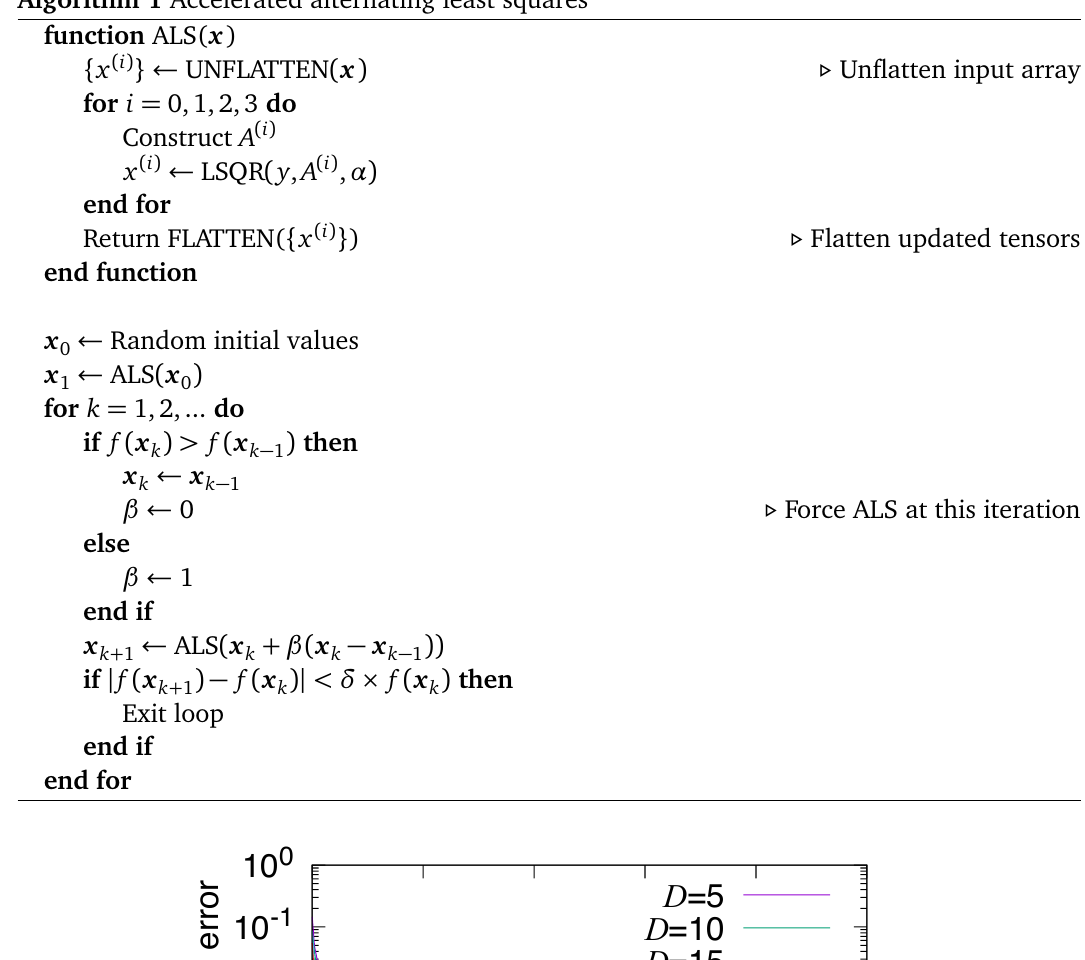
Algorithm 1 Accelerated alternating least squares